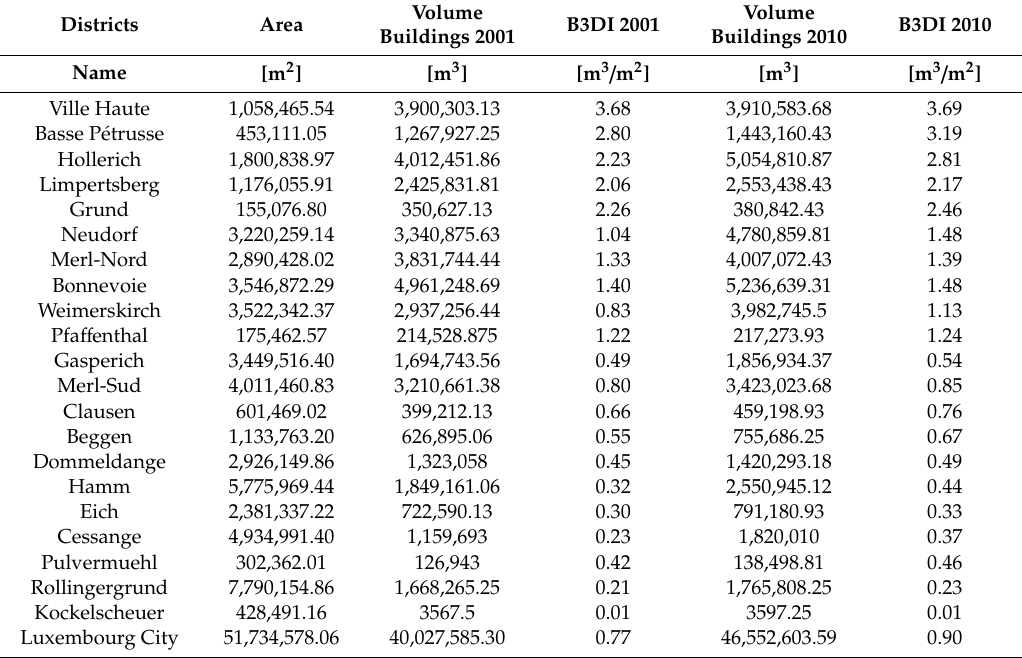
Table A2. Volume of buildings and Building 3D Density Index (B3DI) in Luxembourg City in 2001 and